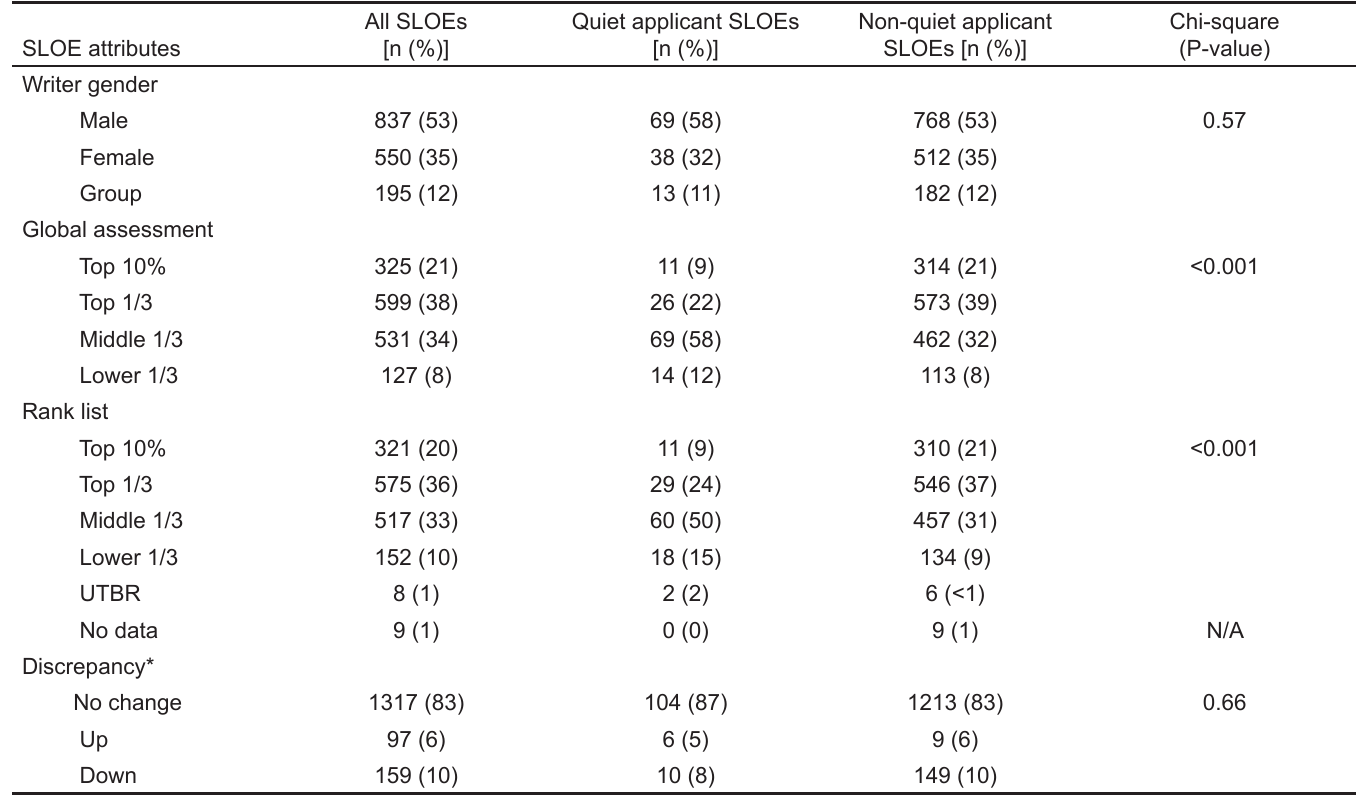
Table 2 . Global assessment and rank list categories for quiet vs non-quiet applicants.